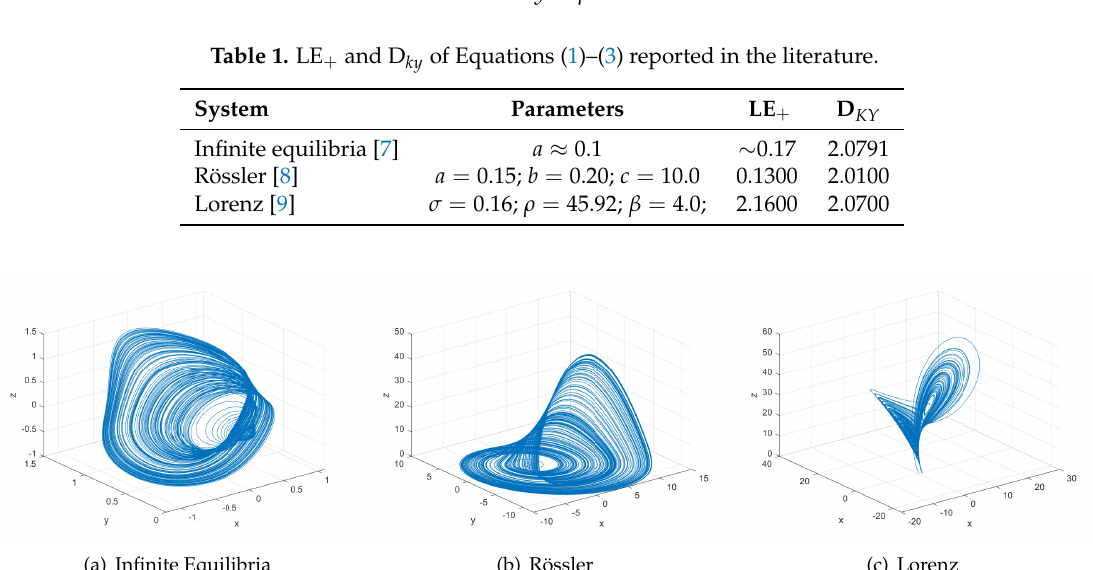
Figure 1. Phase portraits of Equations (1)–(3) with the parameters listed in Table 1, and simulated with a time-step: ( a ) h = 0.3; ( b ) h = 0.0038; and ( c ) h =